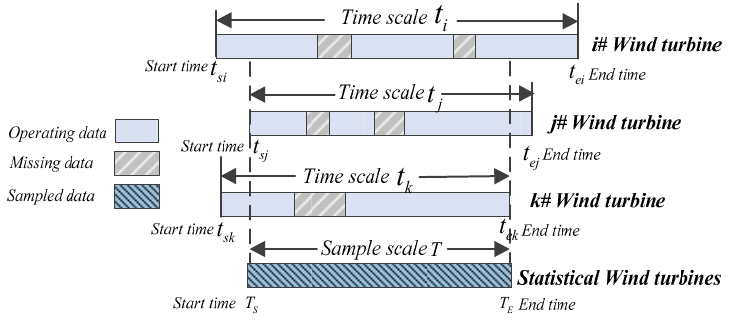
Figure 2. Diagram of wind speed sampling period selection rule.